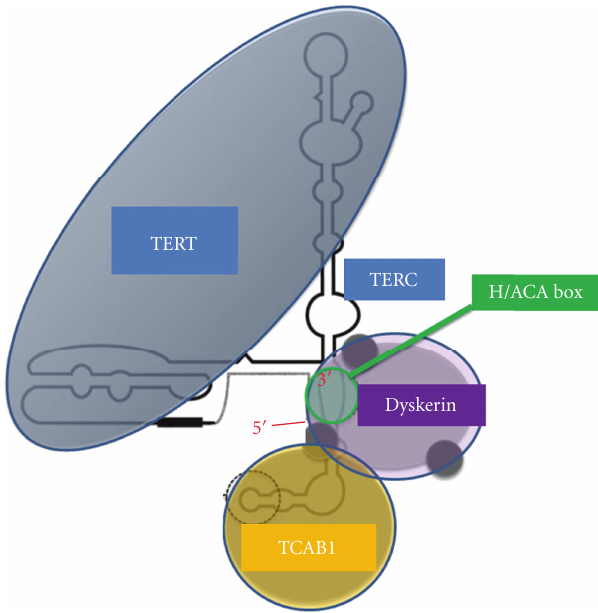
Figure 1: Telomerase